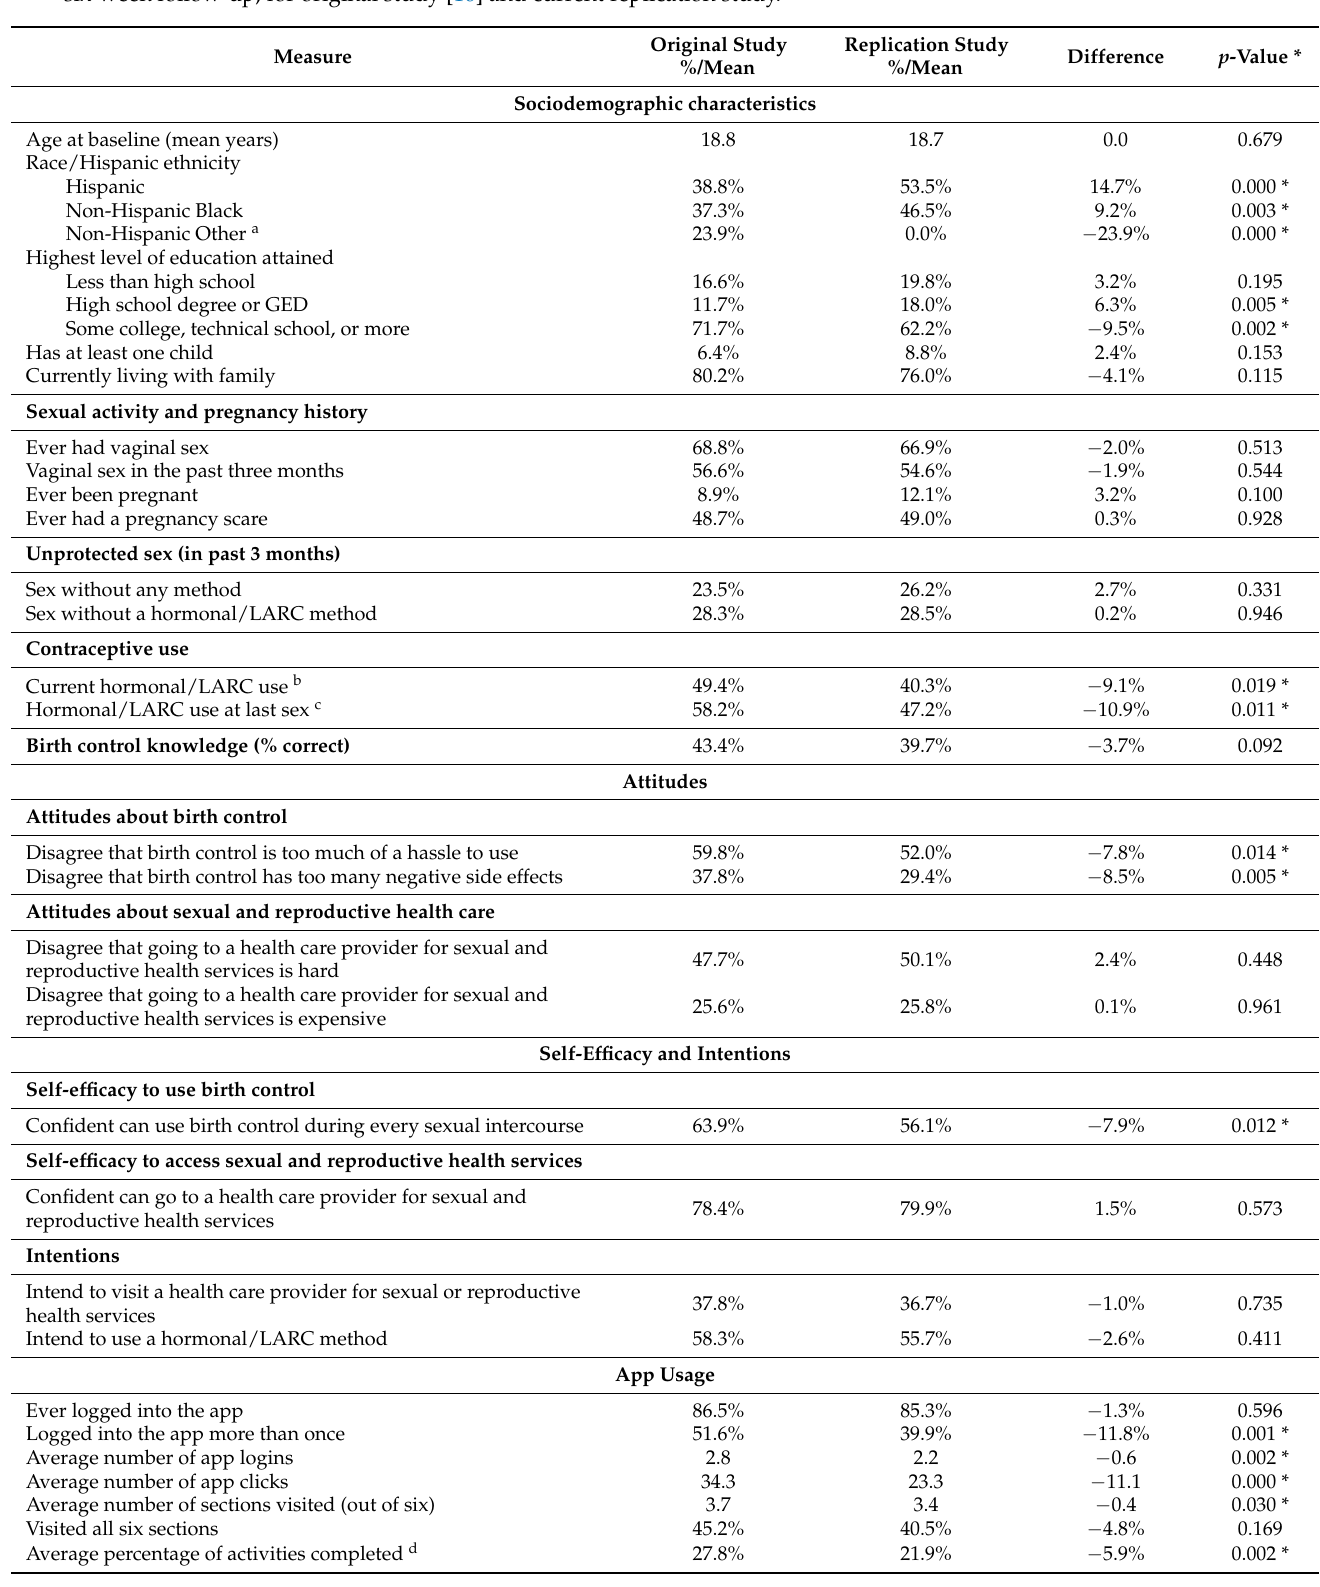
Table 2. Differences in baseline characteristics and usage data of intervention group participants who completed the six-week follow-up, for original study [16] and current replication